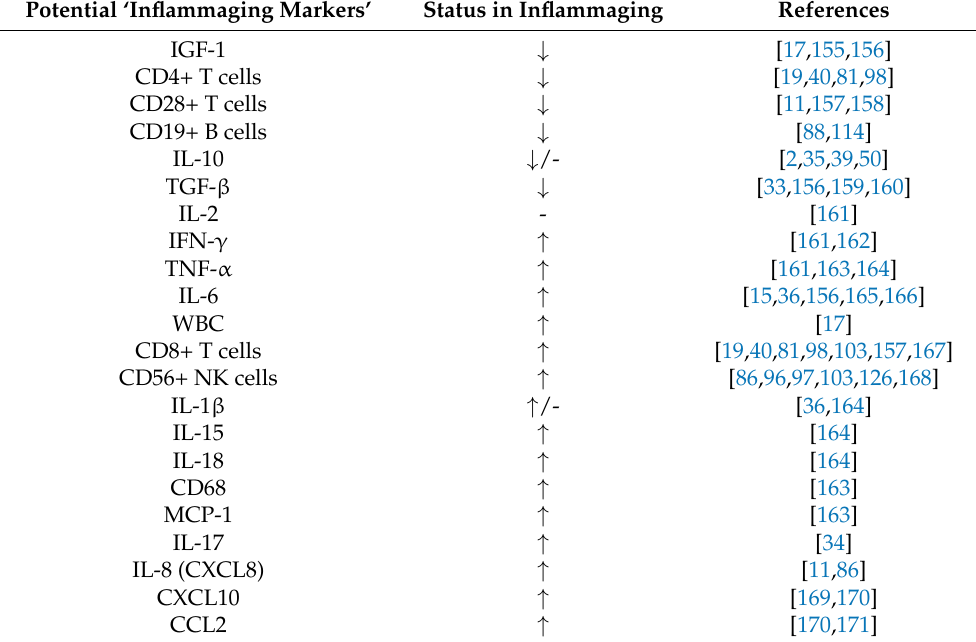
Table 2. The potential ‘inflammaging markers’ related to inflammatory diseases and aging. These markers may be used to validate the efficacy of MSC treatment. (‘ ↓ ’ = decrease; ‘ ↑ ’ = increase; ‘-‘ = no